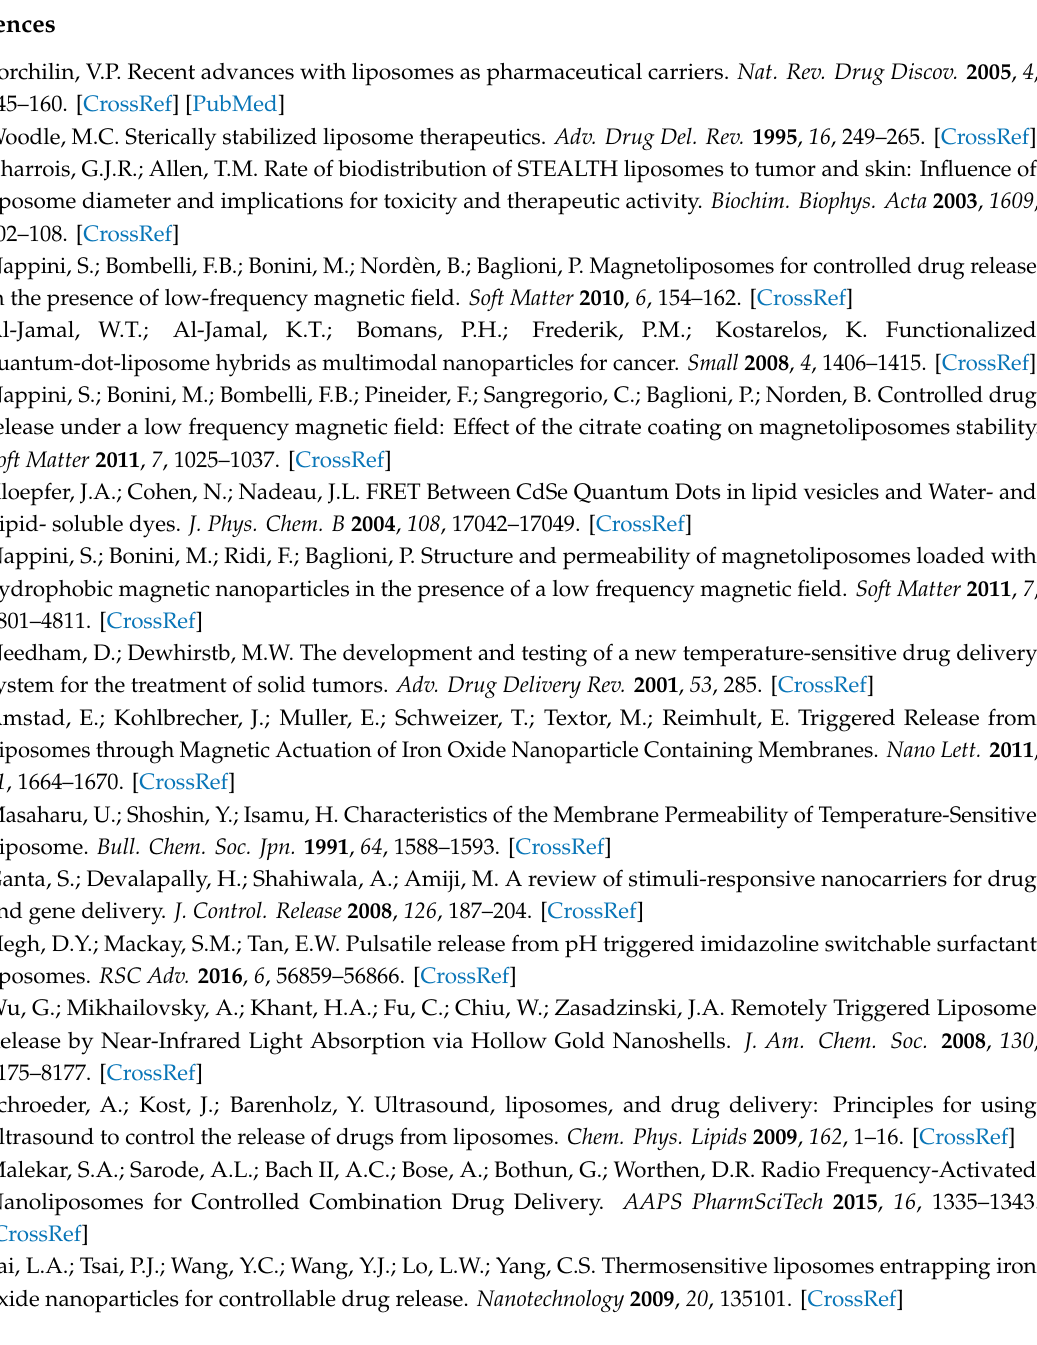
Figure S8. The size distribution of liposomes. Figure S9. The normalized release factor of CF from thiolated liposomes after the completion of Thermal cycle mentioned in Section 4.4. This shows the reproducibility of method of dyes encapsulation as well as CF release assay. Figure S10. The comparison of thermal profile for percentage CF release from di ff erent samples. (n = 6) showing reproducibility of the method